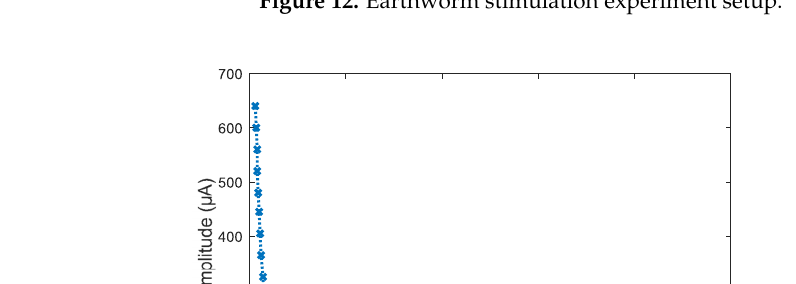
Figure 12. Earthworm stimulation experiment setup.